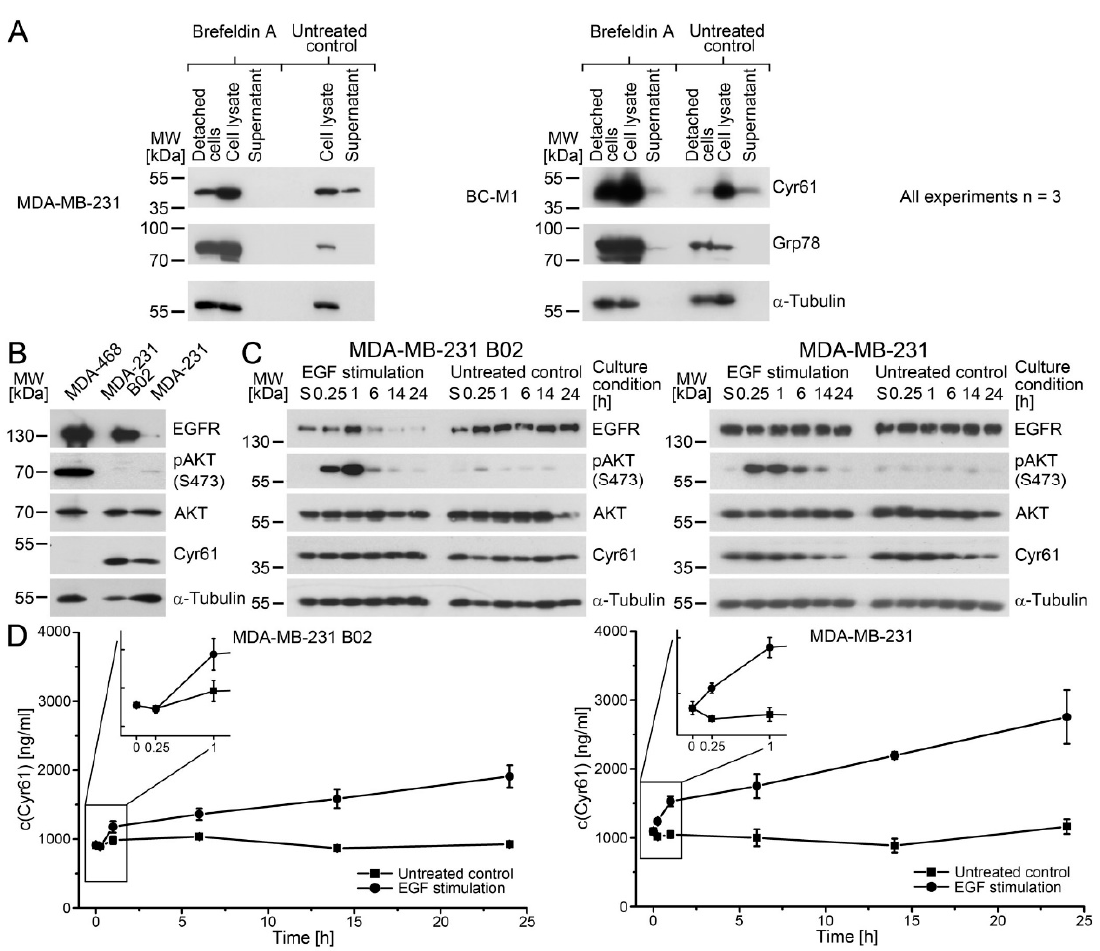
Figure 4. Cyr61 secretion in breast cancer cells. ( A ) Detection of Cyr61 secretion in MDA-MB-231 (MDA-231) and BC-M1 by Western blot analysis. Cells were treated with Brefeldin A to block the protein secretion. The supernatant of the cell culture medium contains the secreted protein fraction, whereas the pellet contains the detached cells. As the total protein amount for two of the three biological replicates of the MDA-231 detached cells (untreated) was below 50 µg, a Western blot lacking this sample is shown. The 78 kDa glucose-regulated protein (Grp78) was analysed as the positive control for a cellular response to Brefeldin A treatment. ( B ) A comparison of the protein levels in the parental cell line MDA-231 and its bone metastatic subline MDA-231 B02 in the non-stimulated state by Western blot analysis. ( C ) The activation of the cells (detected as pAKT S473) upon EGF stimulation, and the analysis of the cytoplasmic Cyr61 levels by Western blot analysis. ( D ) The secreted Cyr61 levels in the cell culture supernatants after EGF stimulation. For a statistical analysis of the values, see Tables S2 and S3. The corresponding scatterplots are shown in Figure S7.